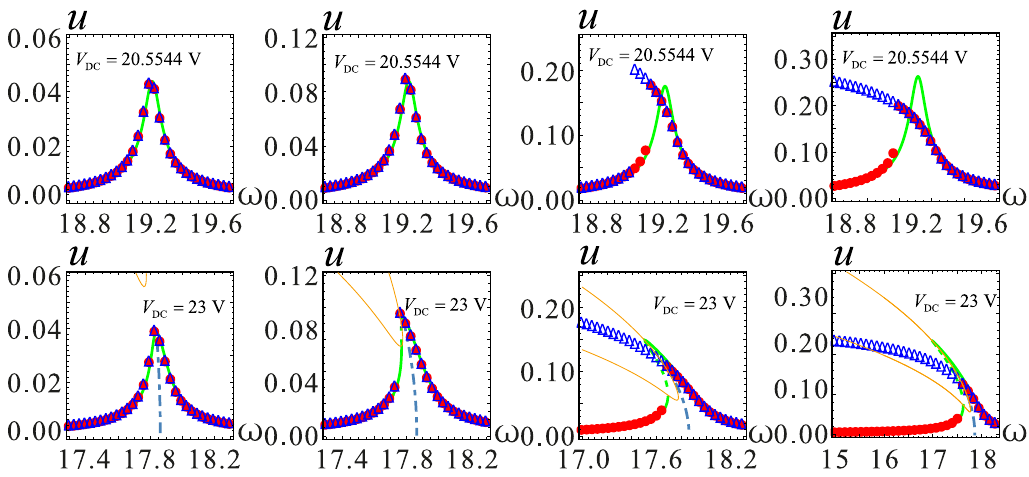
Figure 7. The frequency response changes with AC voltage at λ = 0. The DC voltages are V DC = 15 V, V DC = 20.5544 V and V DC = 23 V, respectively, from top to bottom in the figure. The solid lines represent stable solutions. The dashed lines represent unstable solutions. The point represents a numerical solution.